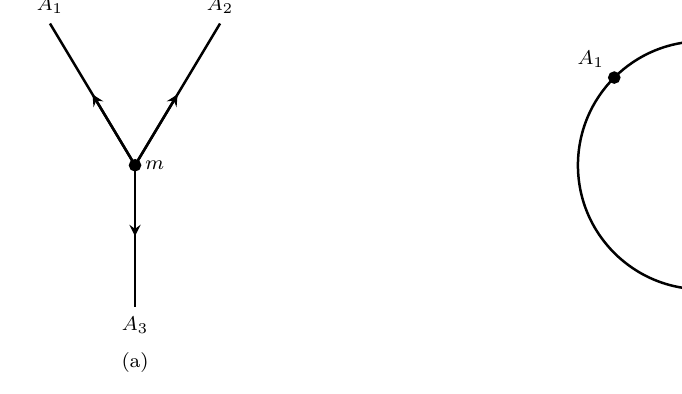
Figure 2 . A morphism m between outgoing lines A 1 , A 2 and A 3 corresponds to a state m